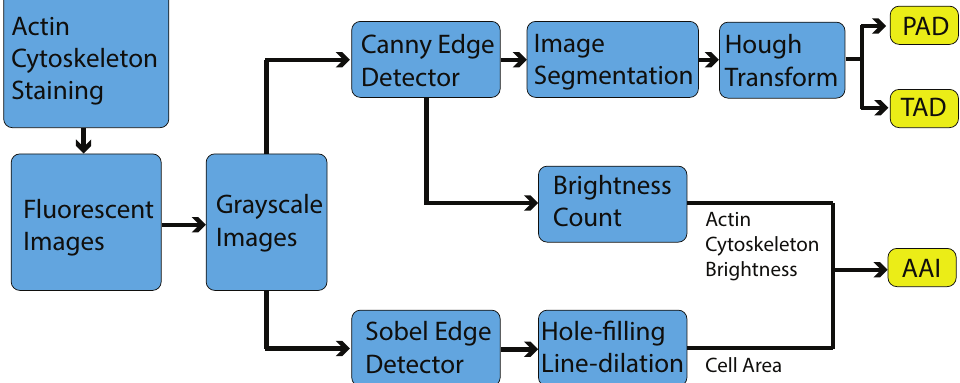
Figure 4. Quantification process of the proposed image recognition-based actin cytoskeleton quantification (IRAQ). PAD, partial actin-cytoskeletal deviation; TAD, total actin-cytoskeletal deviation (TAD); AAI, average actin-cytoskeletal